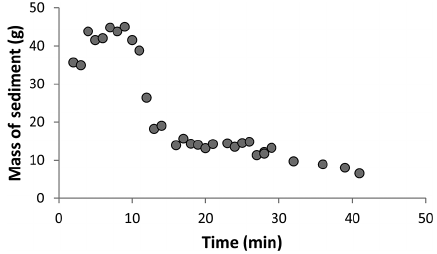
Figure 4. Samples collected for 5s every minute during the first 190L of run 11 show a decrease in sediment load with time after an initial